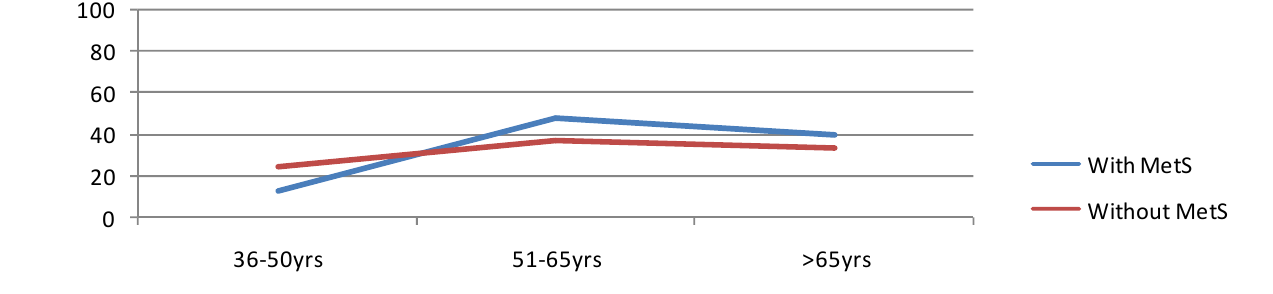
Figure 1. Age group specific prevalence of Metabolic syndrome (MetS).